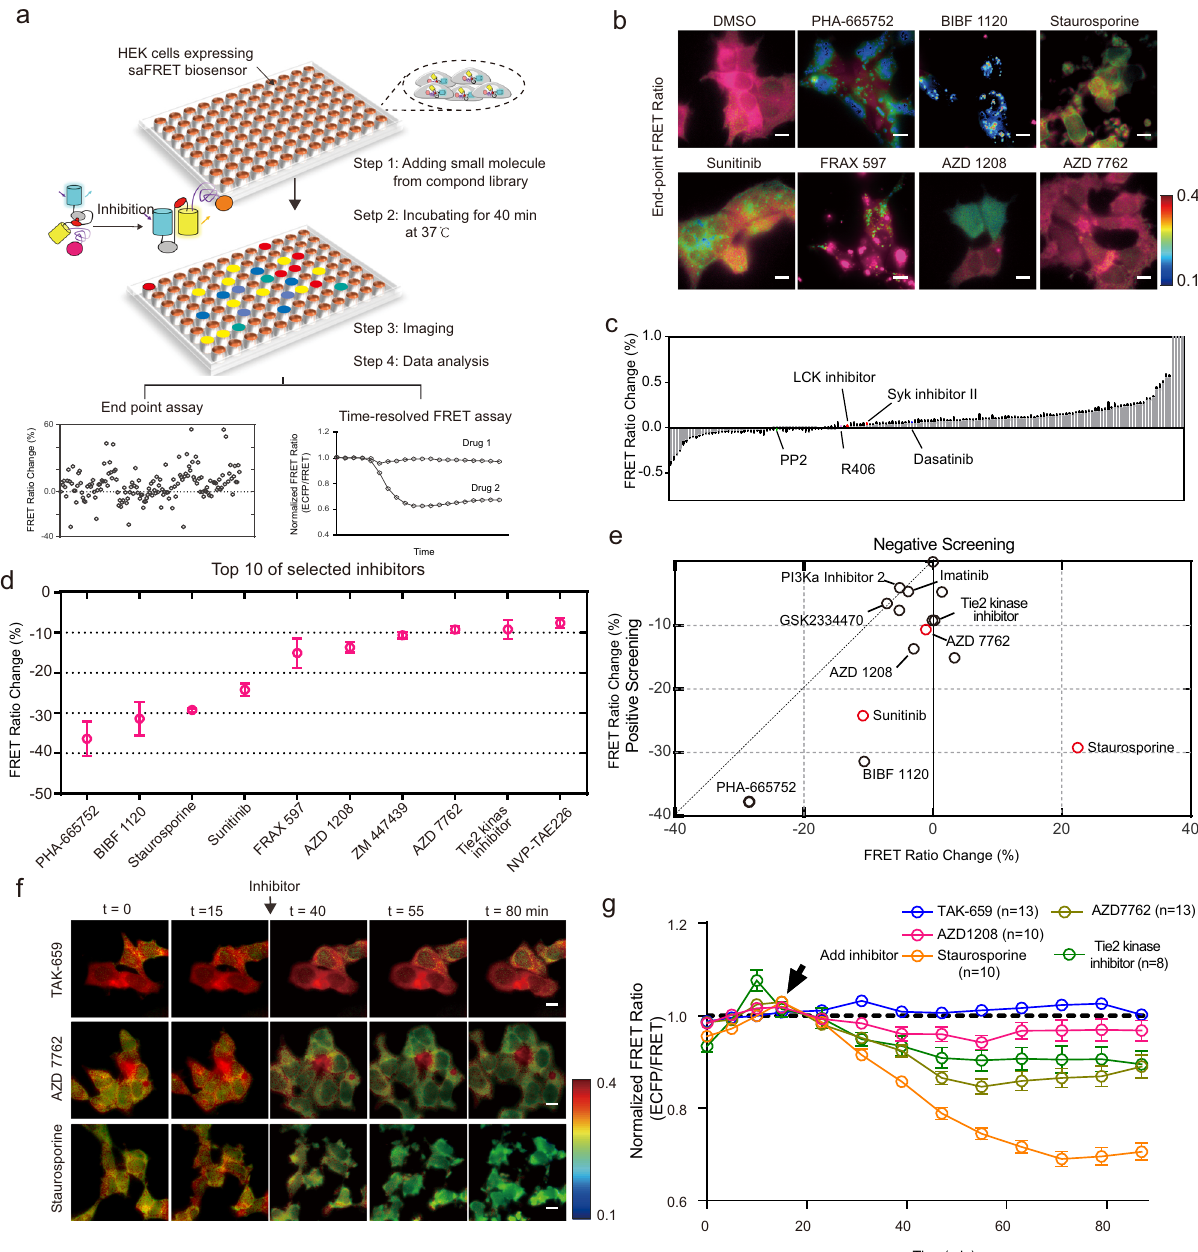
Fig. 6 High-throughput drug screening platform using saFRET biosensor. a Schematics of the high-throughput drug screening platform. First, the cells cultured in 96-well glass-bottom plates were treated either with DMSO or inhibitors from the kinase inhibitor library. After 40min of incubation, the cells were imaged, and the FRET ratio change compared to the control cell was calculated. This platform can also allow dynamic tracking of the FRET ratio change after inhibitor treatment in single cells. b Representative FRET-Ratio images of the cells with different inhibitors corresponding to ( d ). Scale bars, 10 µ m. c Summary of screening results. Some of the inhibitors have shown high ef fi ciency in inhibiting ZAP70 kinase. The highlighted inhibitors represent the inhibitors targeting ZAP70 upstream signaling molecules. Dasatinib, Src kinase inhibitor; PP2, Lck/Fyn kinase inhibitor; R406, Syk inhibitor. d Top 10 selected inhibitors (From left to right, n = 24, 12, 31, 37, 26, 50, 49, 51, 46, and 46, respectively). Error bars, mean±SD. e Counter screening using a mutant biosensor with a kinase-dead domain to subtract the noise engendered from non-speci fi c fl uorescence. The Scatter plot illustrates the FRET ratio changes in the positive and negative screenings using the saFRET biosensor fused with an active kinase or a kinase-dead domain, respectively. f – g Time-lapse FRET ratio images ( f ), and the normalized FRET ratio ( g ) of HEK293 cells before and after inhibitor treatment. The TAK-659 (10 μ M) was used as the negative control, which cannot suf fi ciently inhibit the ZAP70 kinase. ( n is shown in the fi gure). Error bars, mean±SEM. Scale bars, 10 µ m. See also supplementary video 7. Source data are provided as a Source Data fi